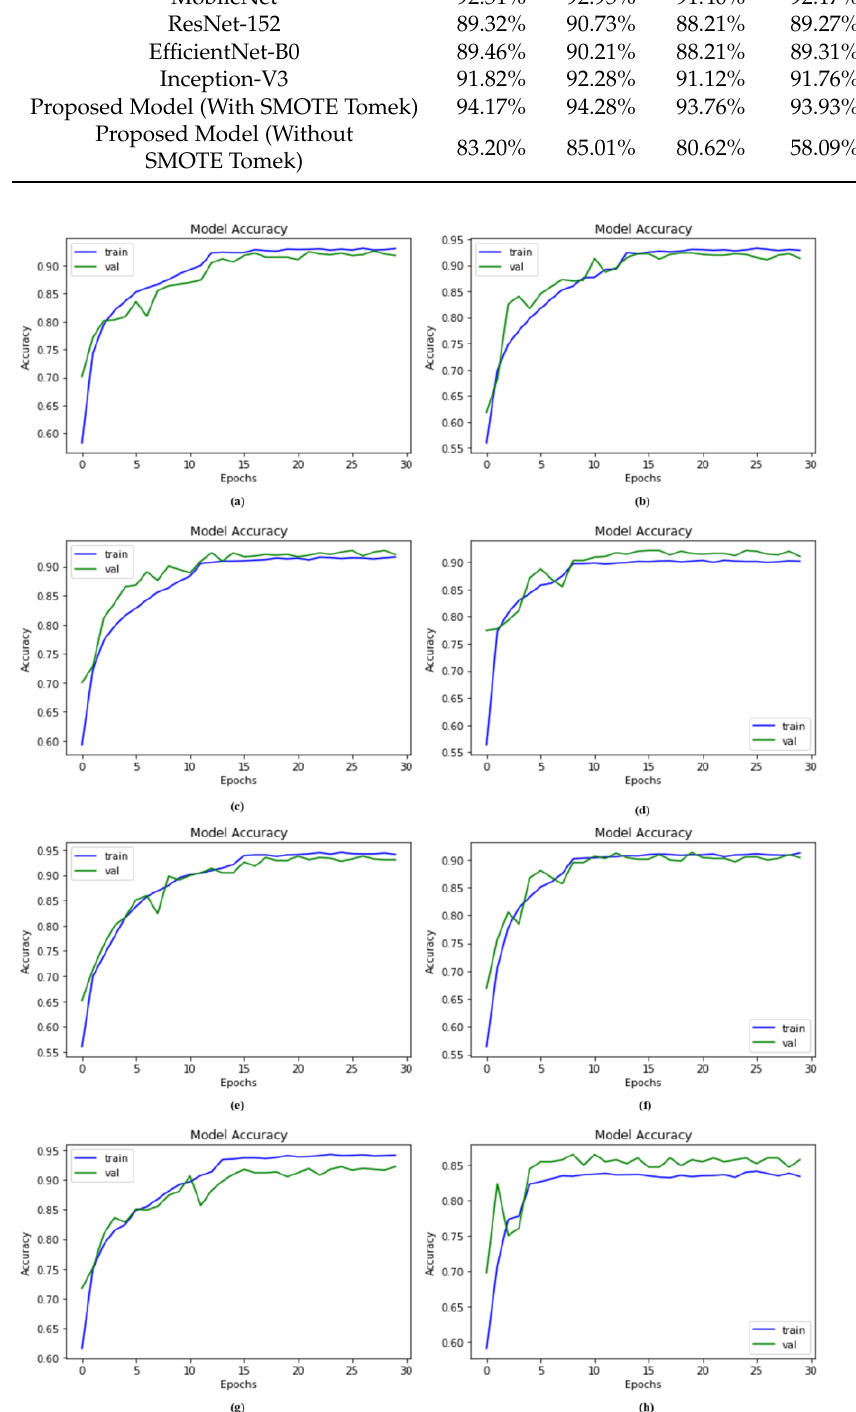
Figure 6. Remarkable accuracy improvement with or without SMOTE Tomek in the proposed model compared to other baseline deep networks; ( a ) Vgg-16, ( b ) Vgg-19, ( c ) EfficientNet-B0, ( d ) ResNet-152, ( e ) Inception-V3, ( f ) MobileNet, ( g ) Proposed Model with SMOTE Tomek, and ( h ) Proposed Model without SMOTE Tomek. Table 5. Performance of the DSCC_Net model compared with baseline algorithms.